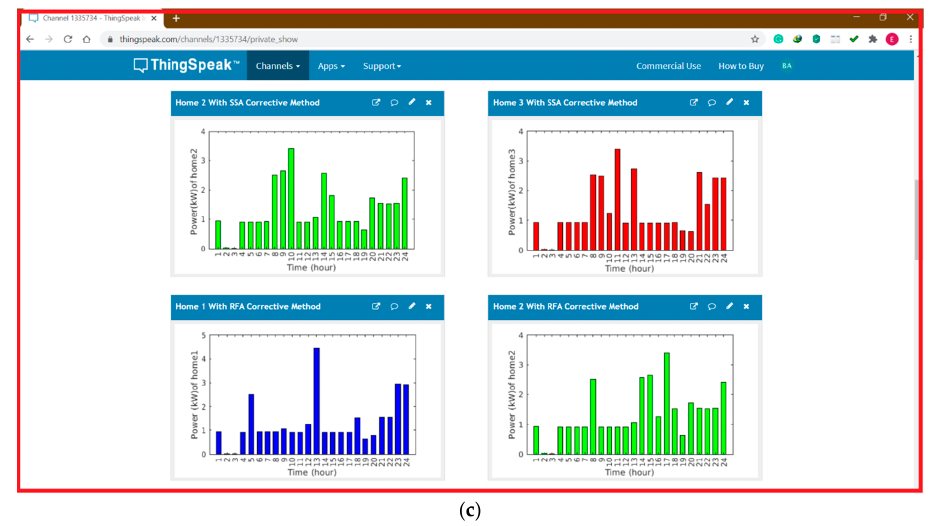
Figure 7. User interface design platform (ThingSpeak platform), ( a ) the ThingSpeak web page to the enter username and password of the customer, ( b , c ) the ThingSpeak dashboard illustrate the results of the proposed system.